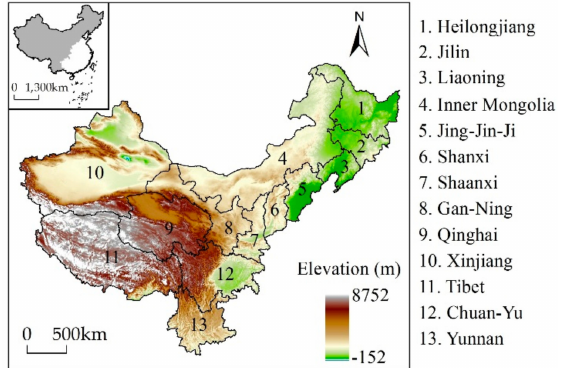
Figure 1. Maps showing the location and topography of grassland across western China. The grassland region encompasses 13 provinces. The digital elevation model (DEM) was obtained from Geospatial Data Cloud (http: // www.gscloud.cn /